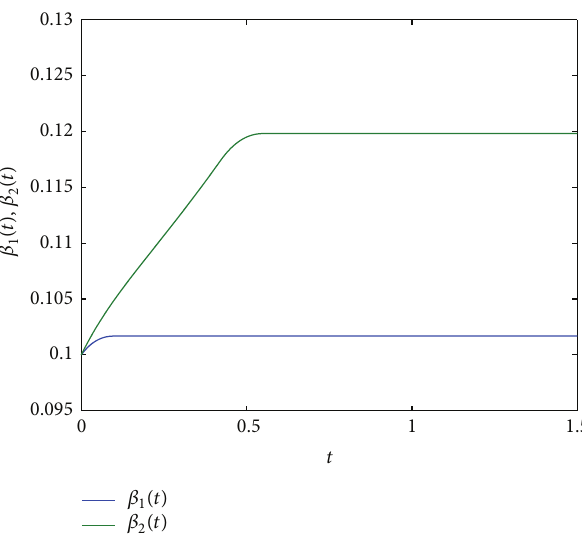
Figure 6: Trajectories of control parameters 𝛽 1 (𝑡) and 𝛽 2 (𝑡)